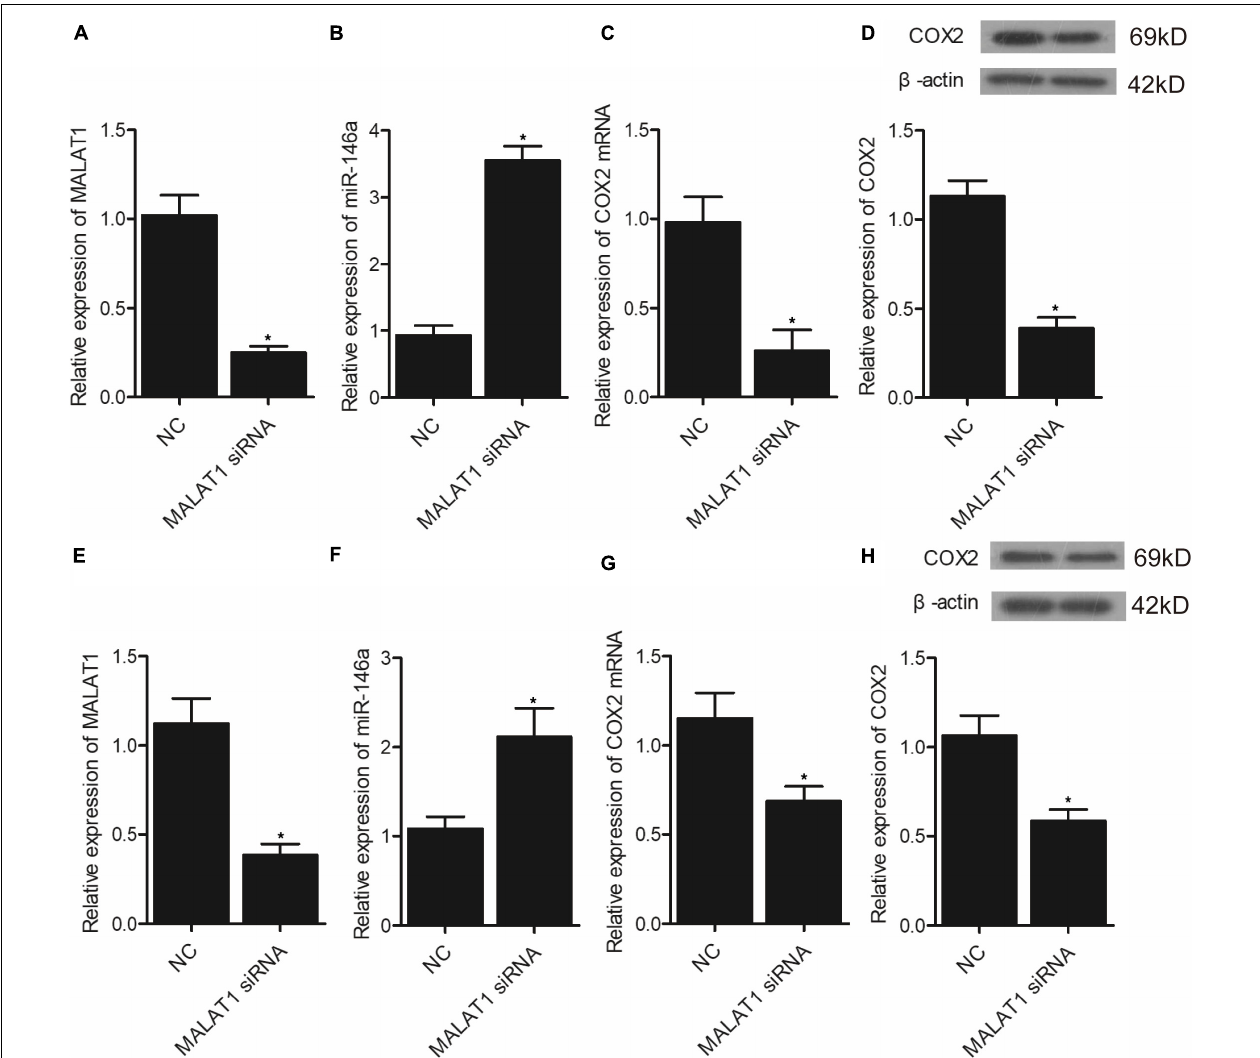
FIGURE 8 | Transfection of MALAT1 siRNA upregulated the expression of miR-146a but downregulated the expression of COX2 mRNA/protein (* p < 0.05 vs. NC group). (A) Relative expression of MALAT1 was inhibited in hPASMCs transfected with MALAT1 siRNA. (B) Relative expression of miR-146a was increased in hPASMCs transfected with MALAT1 siRNA. (C) Relative expression of COX2 mRNA was decreased in hPASMCs transfected with MALAT1 siRNA. (D) Relative expression of COX protein was suppressed in hPASMCs transfected with MALAT1 siRNA. (E) Relative expression of MALAT1 was inhibited in rPASMCs transfected with MALAT1 siRNA. (F) Relative expression of miR-146a was increased in rPASMCs transfected with MALAT1 siRNA. (G) Relative expression of COX2 mRNA was decreased in rPASMCs transfected with MALAT1 siRNA. (H) Relative expression of COX protein was suppressed in rPASMCs transfected with MALAT1